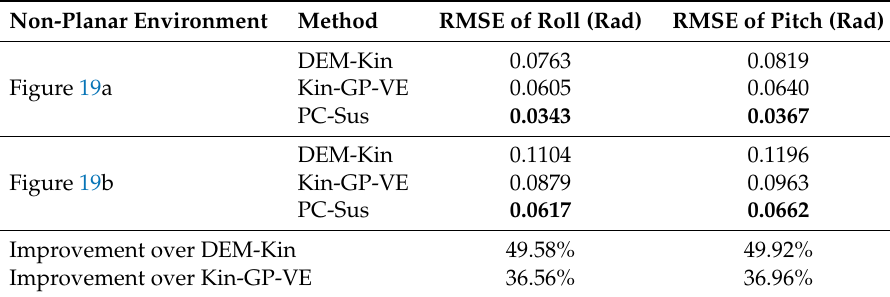
Figure 19. Non-planar environments in the real world. Table 7. The errors of the different pose estimation methods.